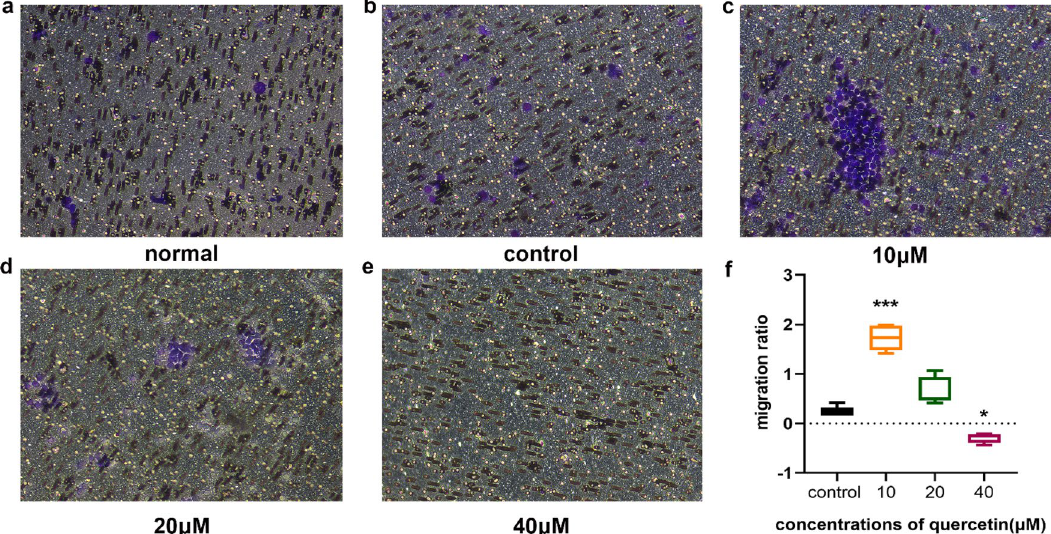
Figure 9. Transwell migration assay was performed to determine the effect of quercetin on T lymphocytes migration. ( a ) The migration of the normal group without the use of quercetin. ( b – e ) The migration of OLP patients with different concentrations of quercetin (control, 10 μM, 20 μM, and 40 μM) respectively. ( f ) The analyzed data indicated that 10 μM quercetin had a positive effect on the migration of OLP T lymphocytes. However, 40 μM quercetin had a significant inhibitory effect on the migration of T lymphocytes (* p < 0.05, *** p < 0.001 versus the control group, n =